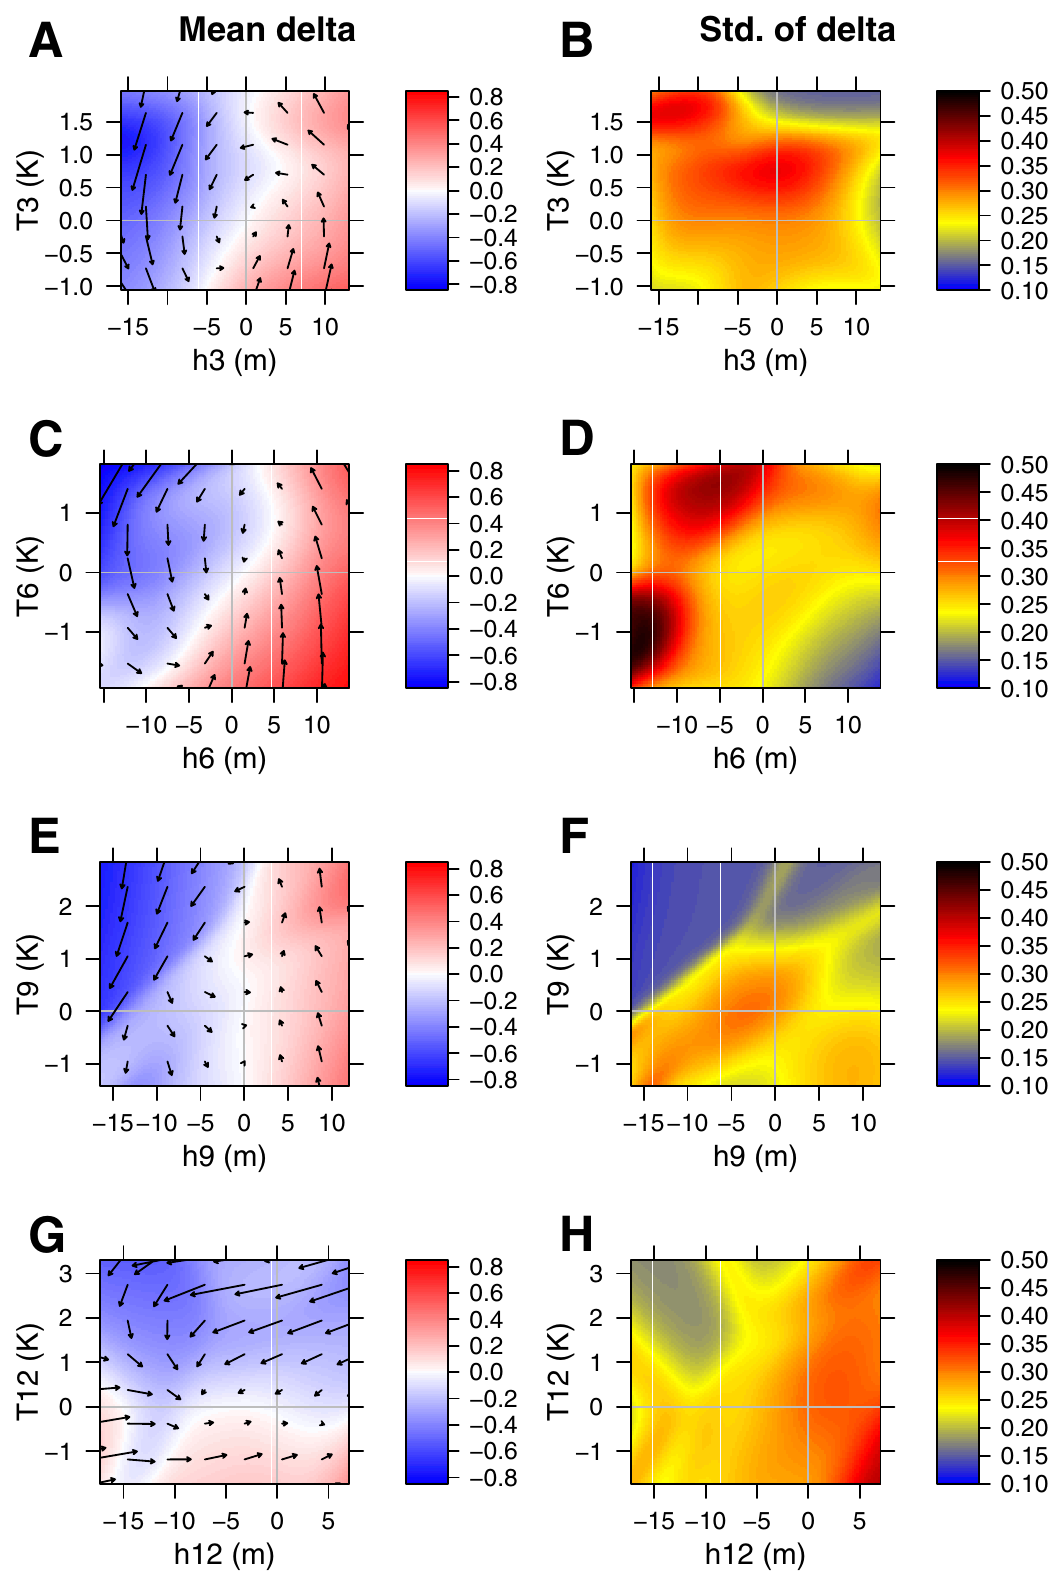
Figure 1. (Left) Mean tendency of SST anomalies in the Niño 3 region for different months (color) [K month − 1 ], as a function of Niño 3 SST anomalies T [K] and equatorial thermocline depth anomalies h [m]. Arrows represent joint tendency of both thermocline depth anomalies [m month − month − 1 ]. (Right) Standard deviation of tendencies of SST anomalies [K month − 1 ] as a function of SST and thermocline depth anomalies. Months are (from top to bottom): March, June, September, and